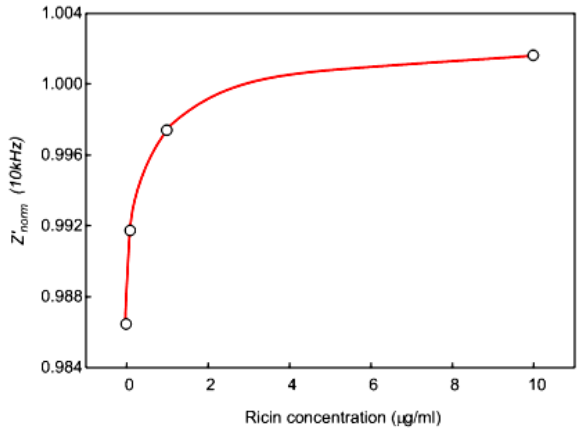
Figure 5. Z’ (10 kHz) at 20 mins from EIS analysis of EII in the differently concentrated norm Ag solutions (0, 0.1, 1, and 10 μg/mL). Ricin, the biological toxin, was used as Ag of